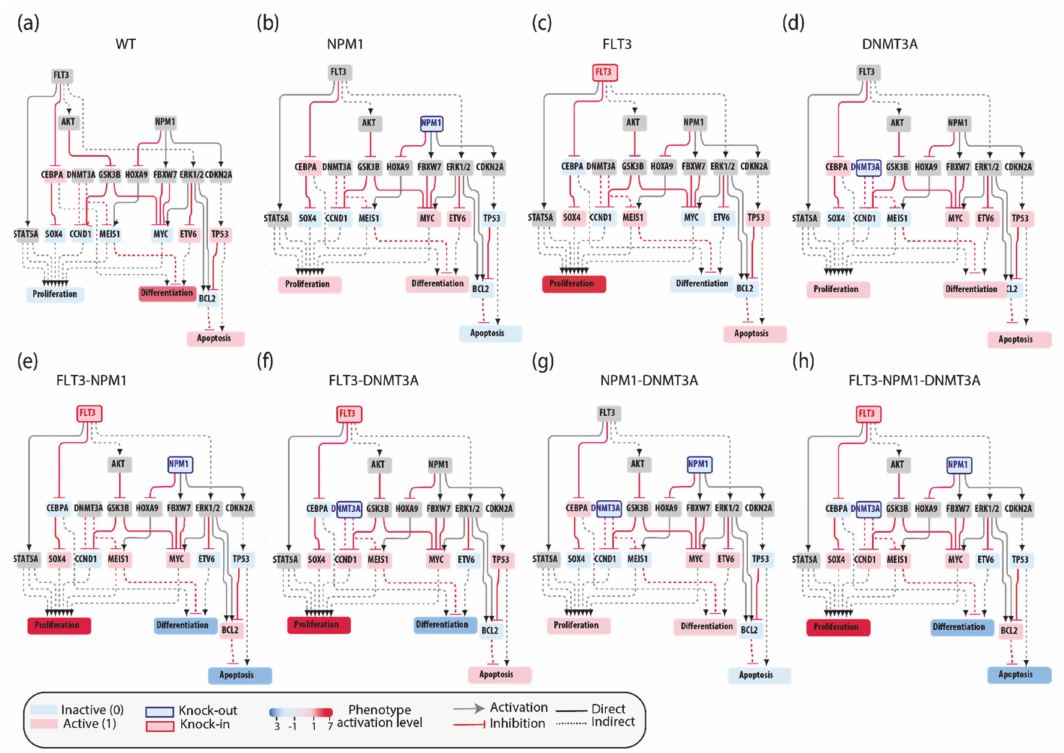
Figure 5. Boolean network simulations of the FLT3/DNMT3A/NPM1 module. In silico simulations of different genomic profiles, including wt ( a ), loss of function of NPM1 and/or DNMT3A and/or gain of function of FLT3 ( b – h ). The nodes are color-coded according to activation level at